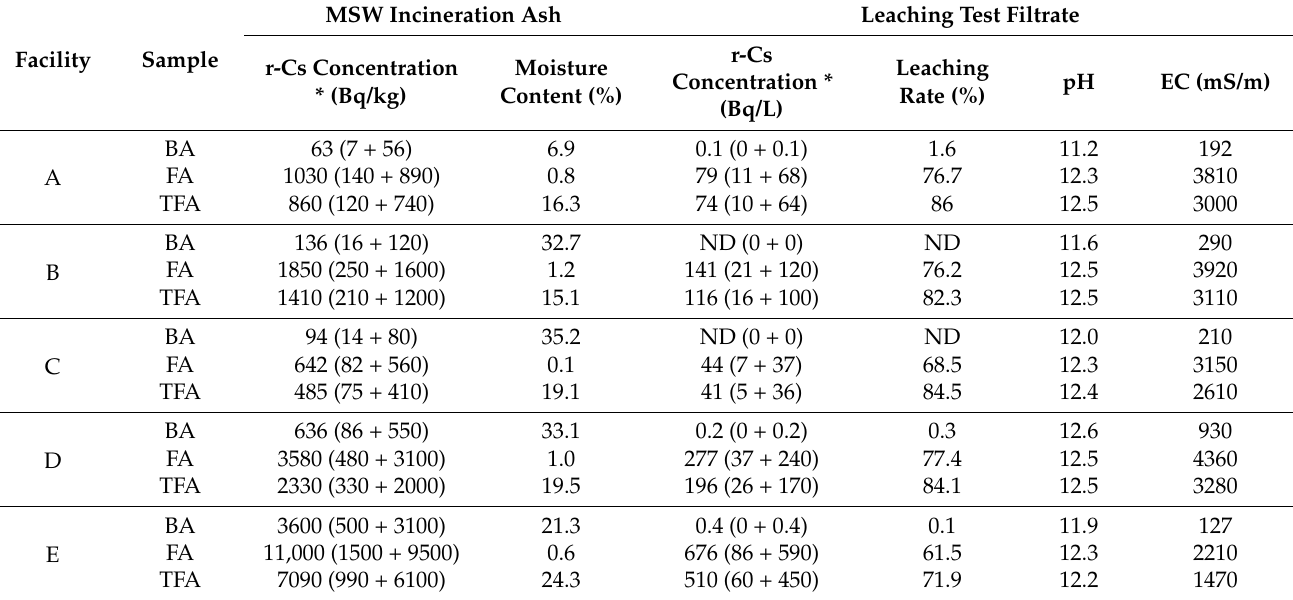
Table 2. Concentration and leaching of radioactive cesium (r-Cs) in February